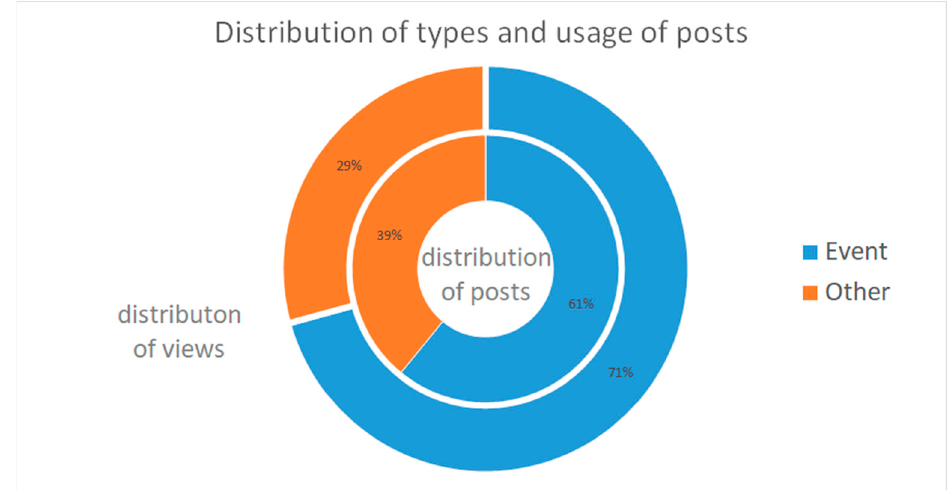
Figure 2. Distribution of types and usage of posts.